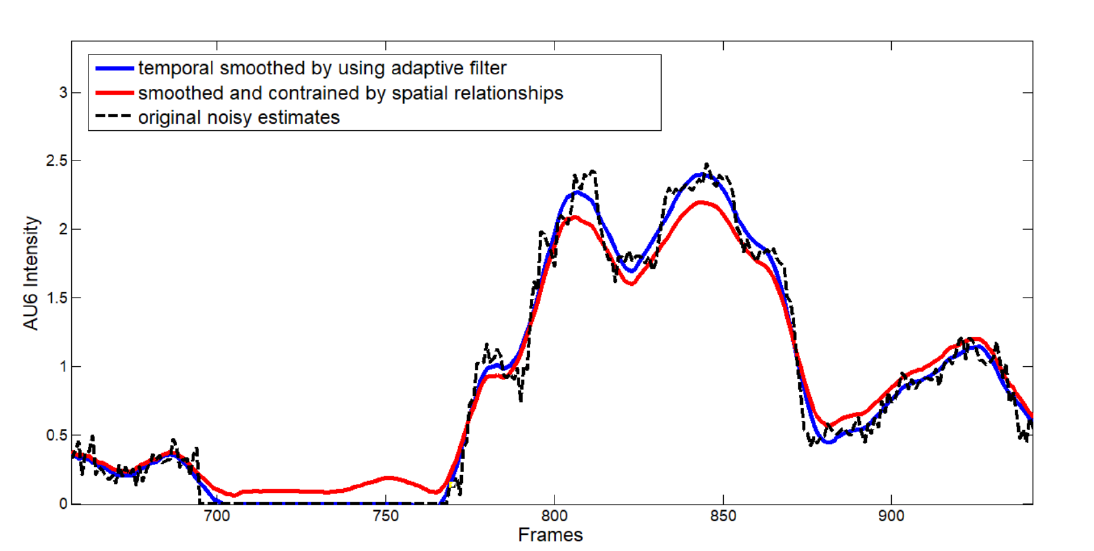
Figure 3. An example of regularized estimates for